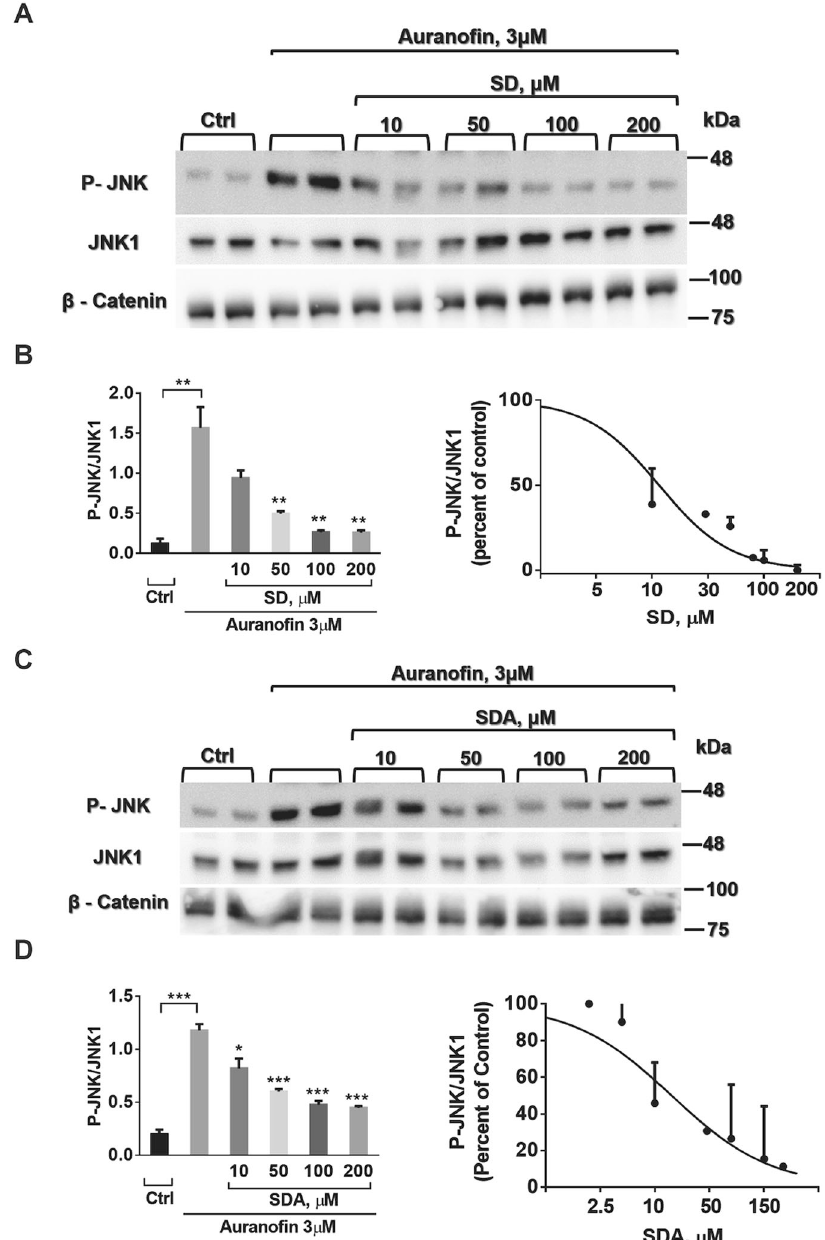
Fig. 4 SD and SDA reverses the aurano fi n-induced phosphorylation of JNK in human neuroblastoma SH-SH5Y cells. A , B SH-SY5Y cells were incubated with 3 μ M aurano fi n (Auf) for 30 min, washed, and treated with or without increasing concentrations of SD in 4 independent experiments. C , D SH-SY5Y cells were incubated with 3 μ M aurano fi n (Auf) for 30 min, washed, and treated with or without increasing concentrations of SDA in 3 independent experiments, as indicated. Cell lysates proteins in equal amounts were separated on 10% SDS-PAGE, and analyzed by immunoblotting with the corresponding antibodies. The blots were cut prior to hybridization with antibodies shown in Fig. S8. The ratios of phosphorylated JNK to unphosphorylated JNK, or β -catenin were calculated. The values shown are averages (±SEM) based on four independent experiments, normalized to the phosphorylation state of cells treated with Auf after 3.5 h and plotted with a linear regression program. Student ’ s t -test (two populations) was performed for AuF treated cells. * P value < 0.05; ** P value < 0.01; *** P value < 0.005. SD and SDA reverse Auf-induced p38 MAPK phosphorylation The reduction in Auf-induced JNK phosphorylation mediated by SD or SDA was concentration-dependent with apparent Next, the ability of SD and SDA to reverse Auf-induced p38 MAPK dissociation constant of Ki = 50.2 ± 1.1 µM, and Ki = 14.2 ± phosphorylation was examined in SH-SY5Y cells. The cells were 1.4 µM, respectively. Hence, by inhibiting JNK1 phosphoryla- treated for 30 min with 3 μ M Auf, washed, and incubated for 3.5 h tion, SD and SDA inhibit the MAPK-in fl ammatory/apoptotic at 37 °C, with or without SD (Fig. 5A) or SDA (Fig. 5B) (see Fig. S9), pathway. at the indicated concentrations. Phosphorylation of p38 MAPK was